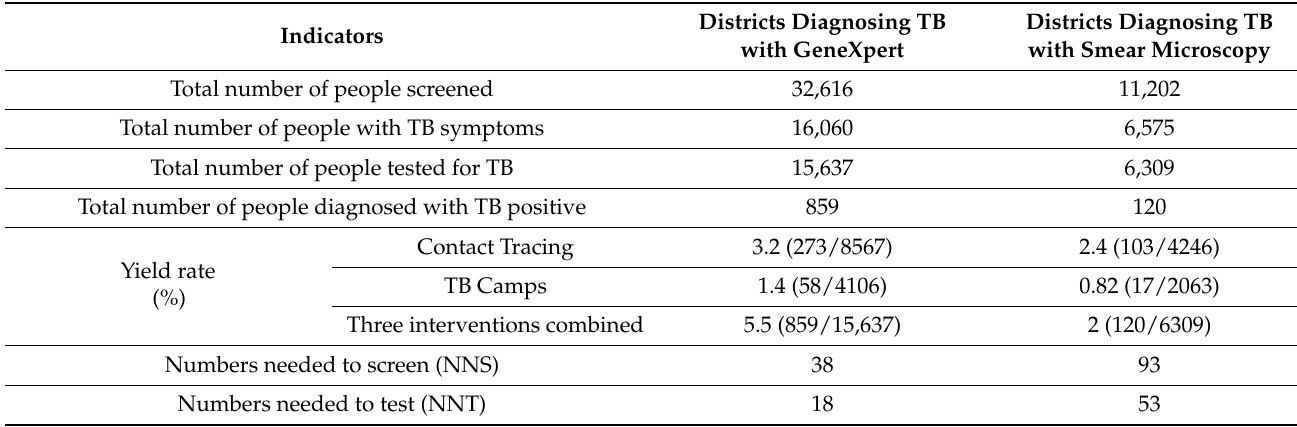
Table 1. Comparison between districts using GeneXpert and smear microscopy as (tuberculosis) TB diagnostic tool (excluding Salyan and Arghakhanchi districts). Districts Diagnosing TB Indicators with